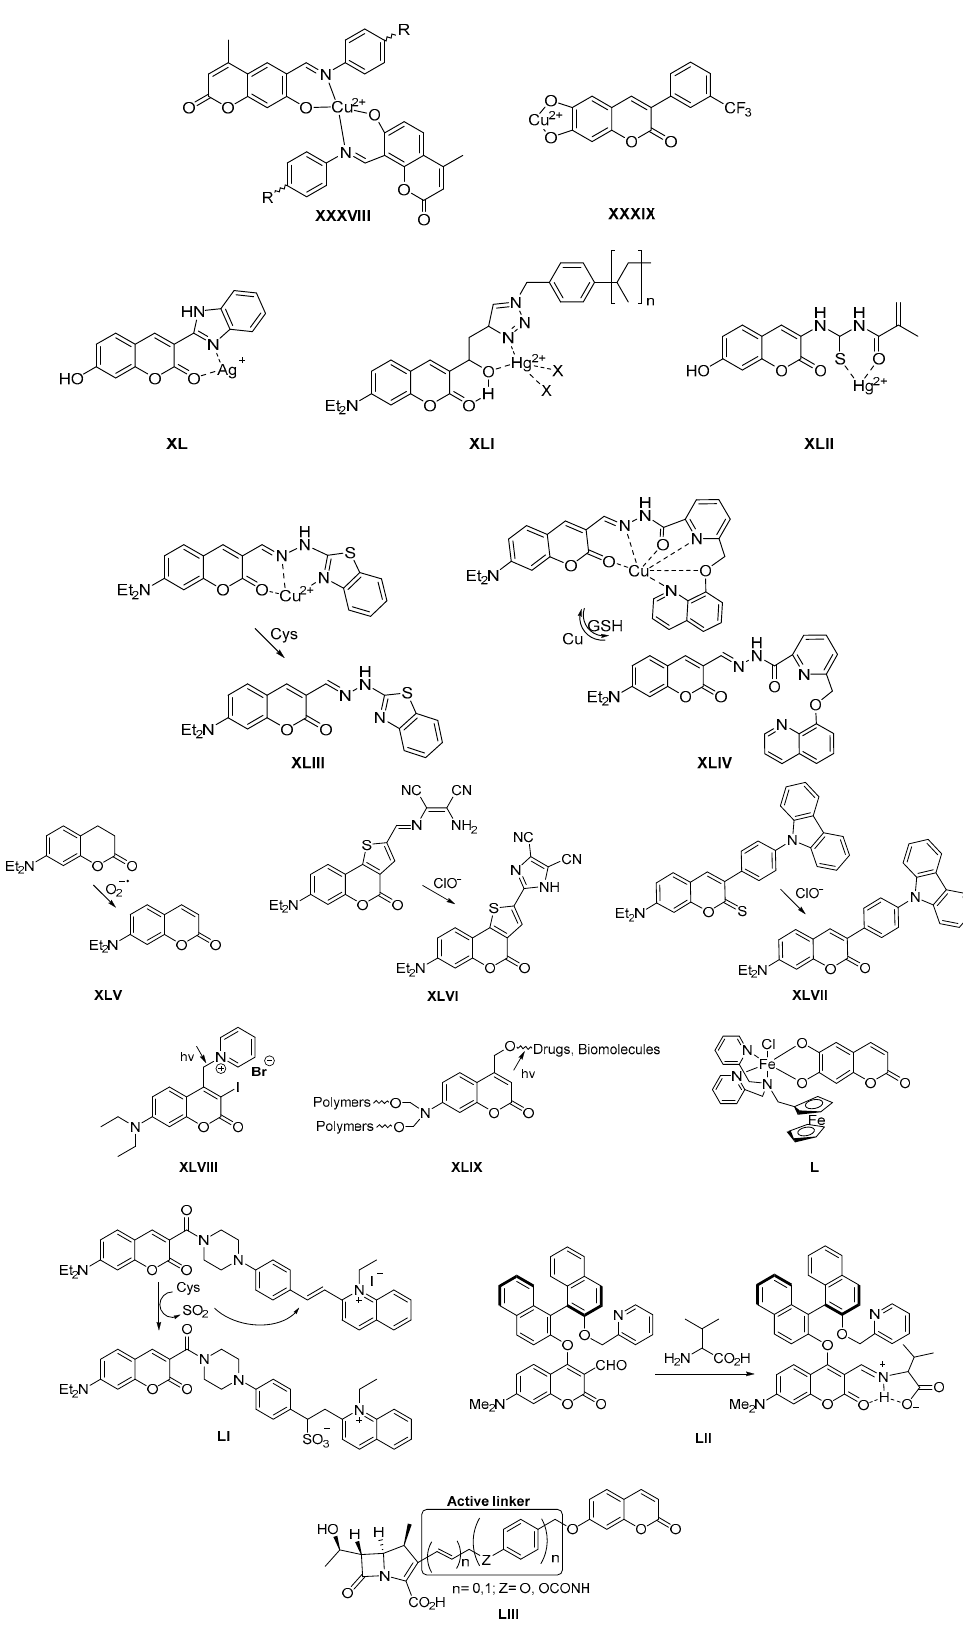
Figure 8. Structures of coumarin derivatives as fluorescent probes.